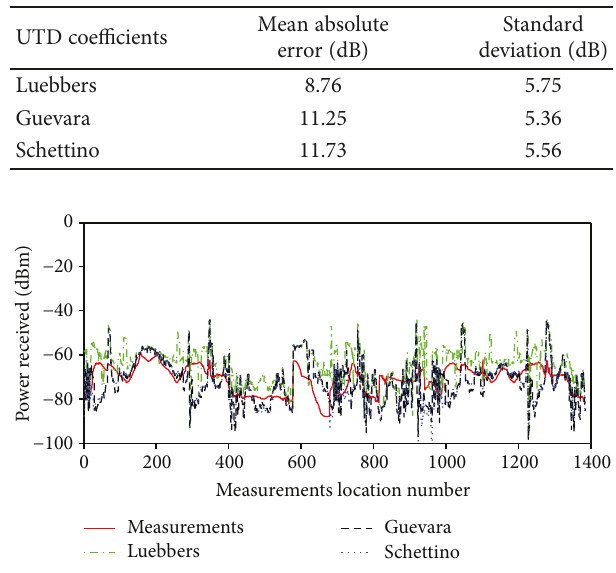
Figure 20: Comparison between ray tracing using the heuristic UTD coe ffi cients and data (red line) for the city of Valencia. Table 7: Statistics of the path loss prediction for